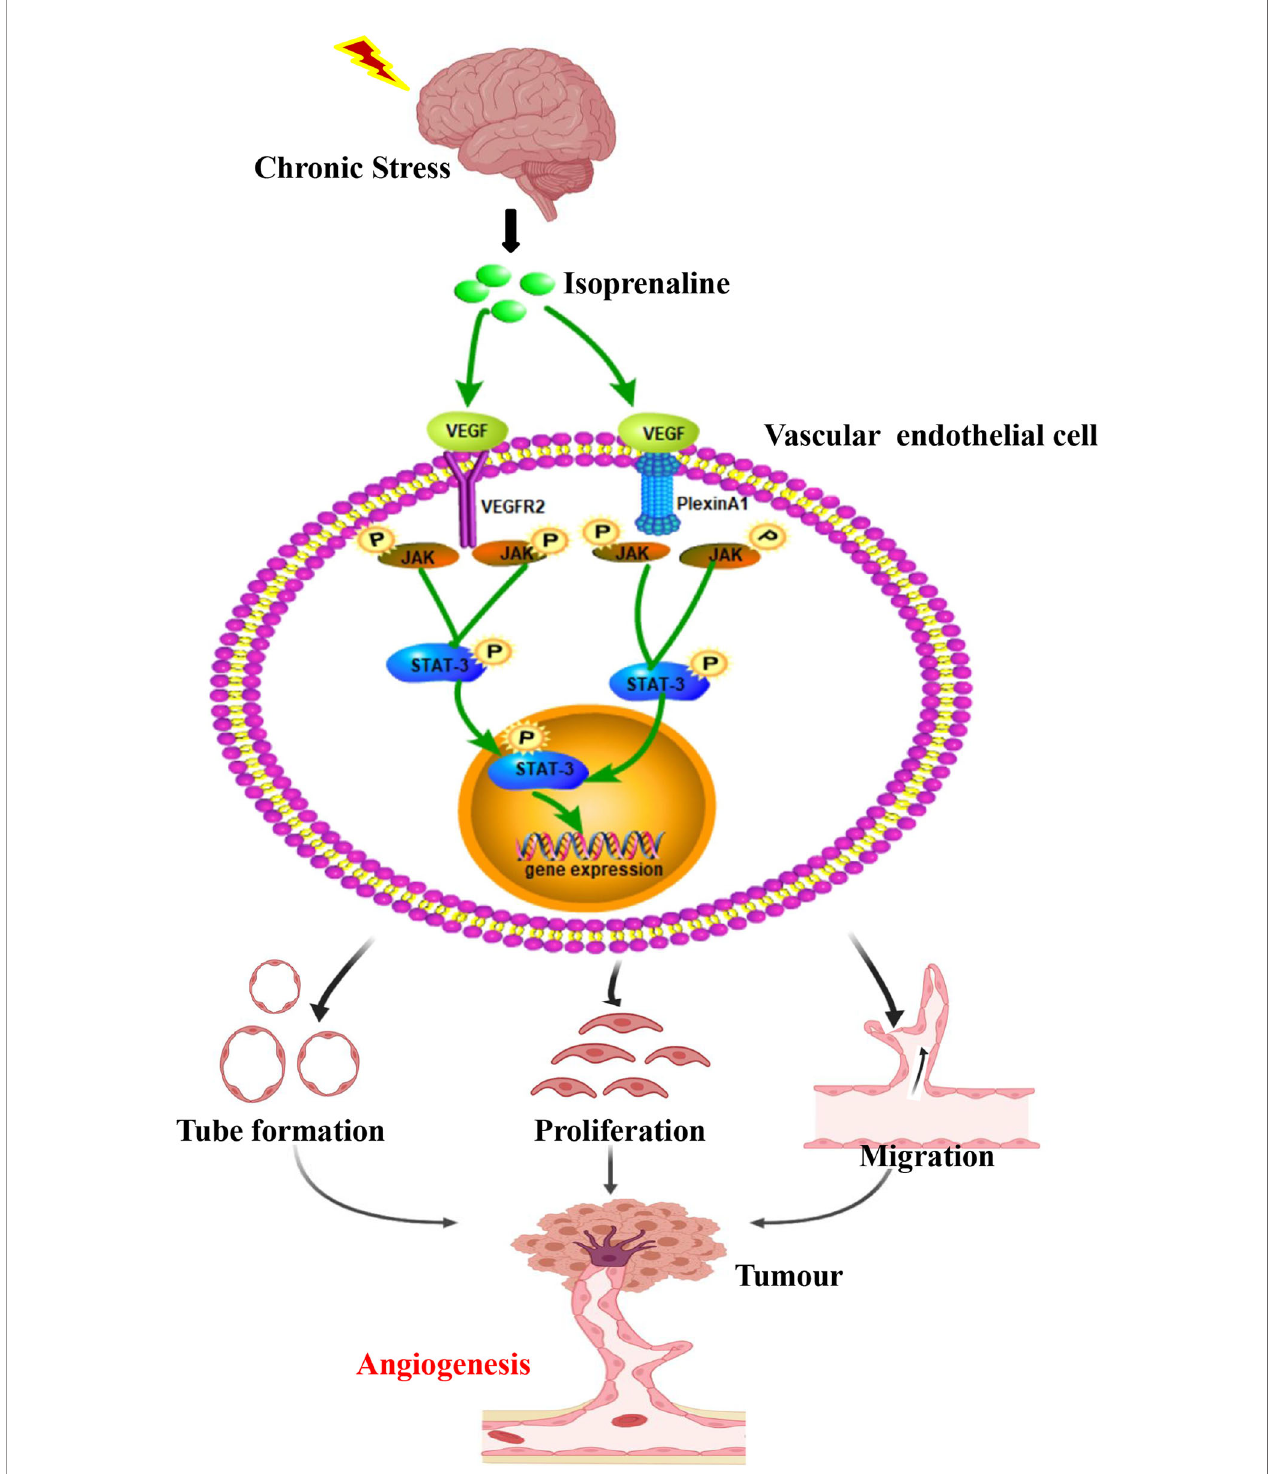
FIGURE 5 | Chronic stress induced tumour angiogenesis. This study suggested that stress-related hormones were directly connected with tumour angiogenesis. Based on this fi ndings, a majority of cancer cases suffered from depression and anxiety to certain degrees, which trigger body release catecholamines. The b 2-AR agonist isoprenaline activated VEGF autocrine of vascular endothelial cells, which subsequently recognized and activated their receptors VEGFR2. PlexinA1 is necessary in the process of VEGF activated VEGFR2 and further affected the ability of proliferation, migration and tube formation of VECs through activating JAK2- STAT3 signaling pathway. Thus, chronic stress promote plexinA1/VEGFR2-JAK2-STAT3 in VECs to promote tumor angiogenesis.